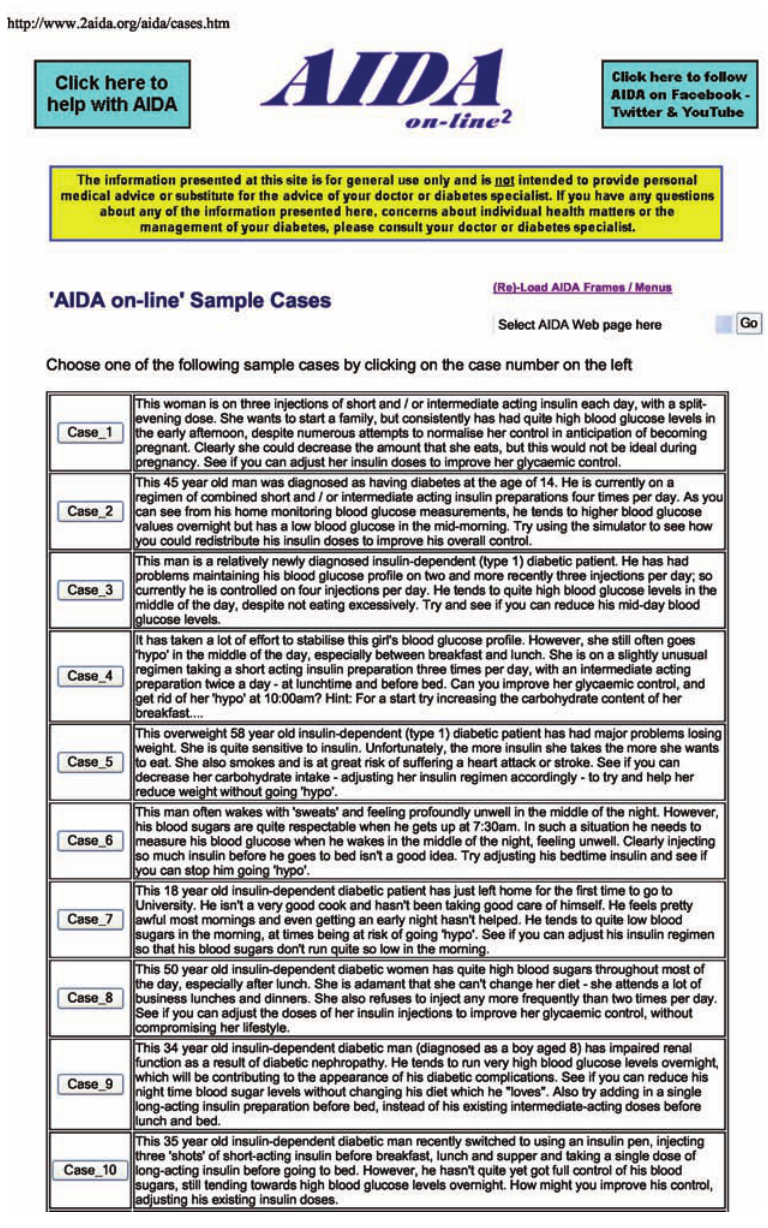
Figure 3: (a) AIDA online 2 main options.htm Case Selector screen shown accessed via Internet Explorer on a Windows XP personal computer. The display shows how a list of summaries of each case scenario can be accessed via a pull-down menu. In this example, a NEW CASE is highlighted. (b) AIDA online 2 intro.cgi dynamically generated HTML page created based on the NEW CASE selected shown in